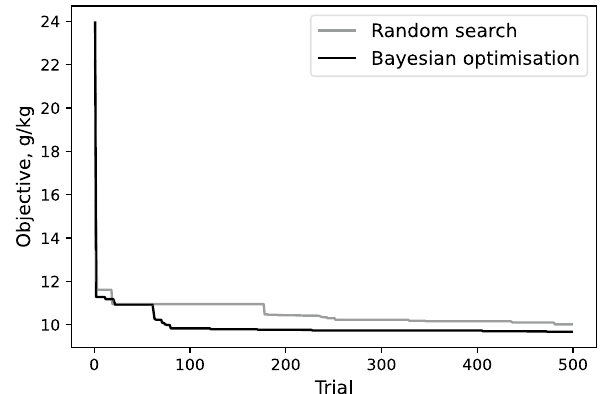
Figure 1. Comparison of the hyperparameter search history from random search and the Bayesian